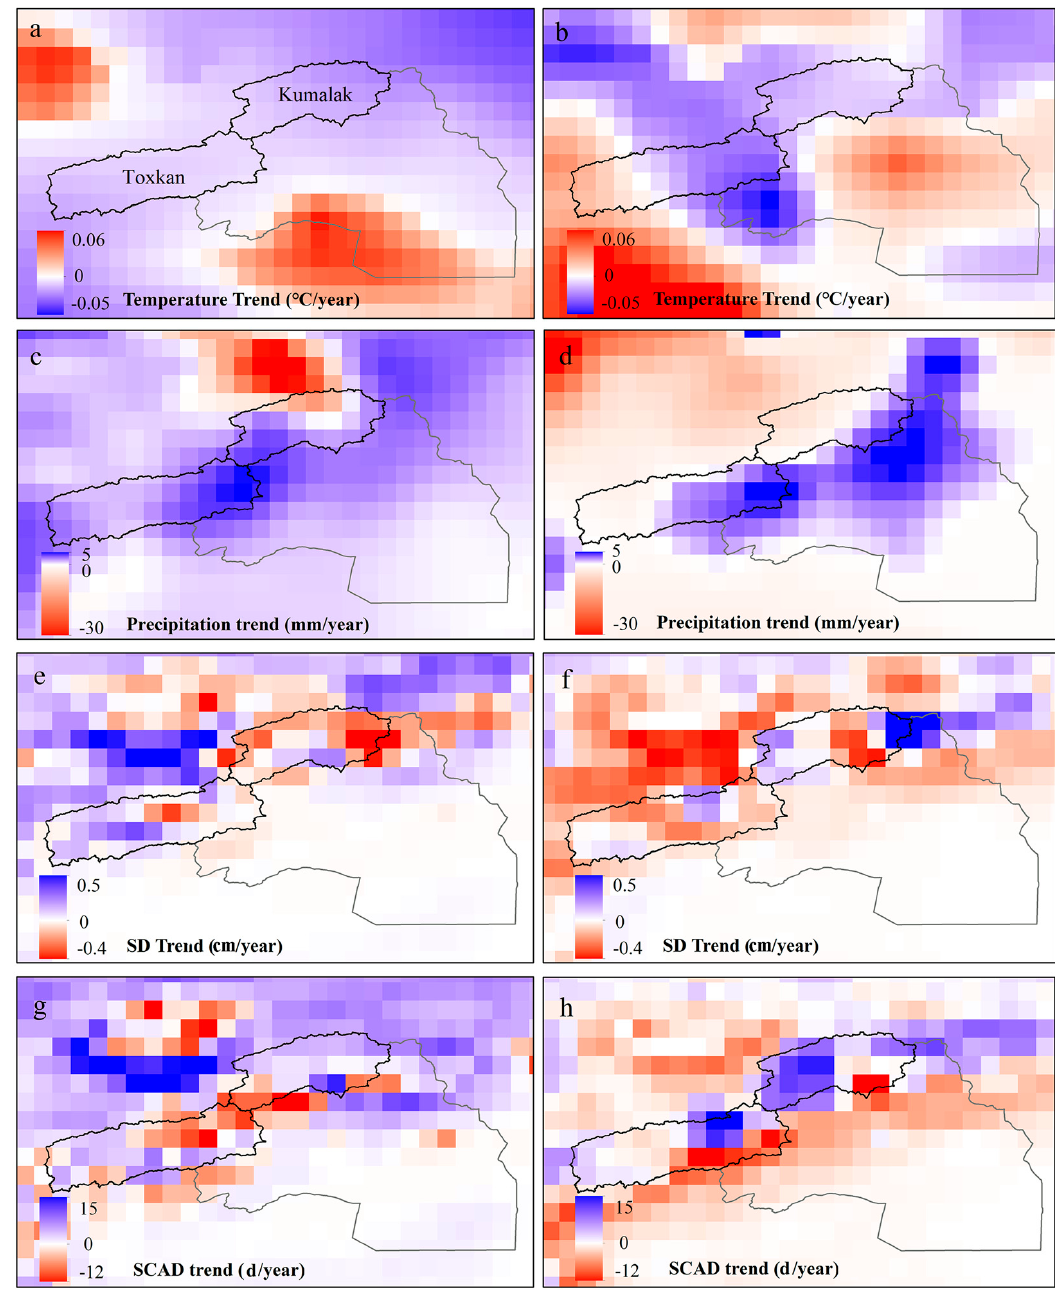
Figure 4. The spatial pattern of temperature, precipitation, SD, and SCAD change rates in the study area during 1979–2002 and 2002–2015. ( a , c , e , g ) Spatial change rates of temperature, precipitation, SD, and SCAD change rates during 1979–2002; ( b , d , f , h ) spatial change rates for the same factors from 2002 to